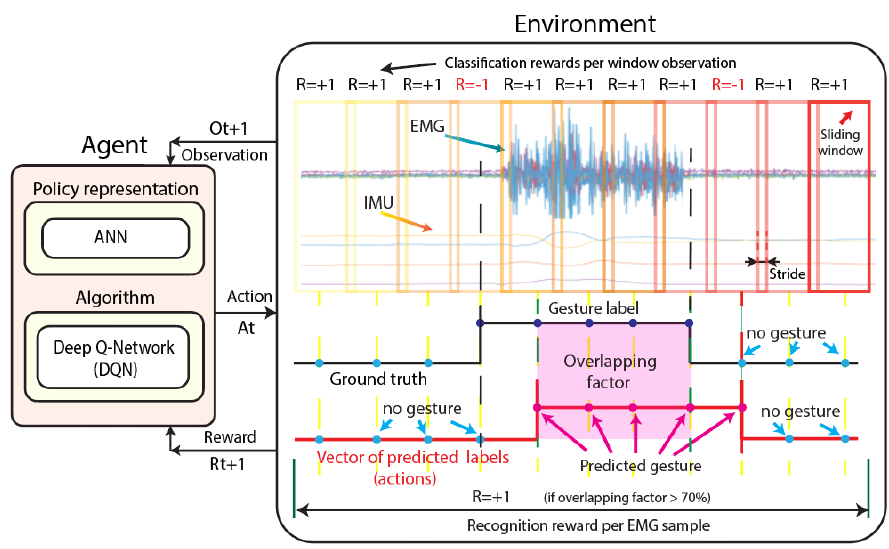
Figure 2. Scheme of the interaction between the DQN agent representation and the proposed environment for the EMG-IMU